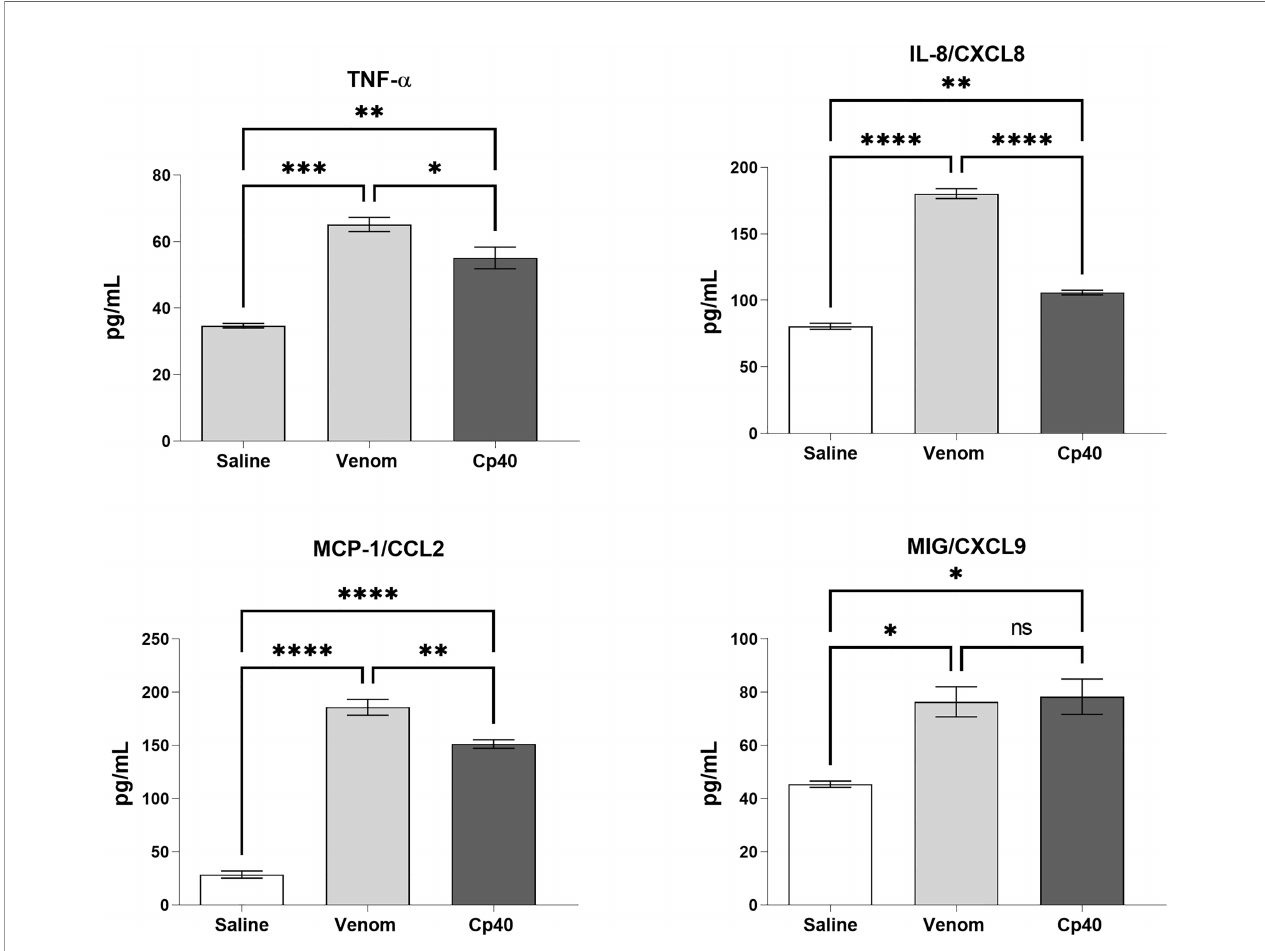
FIGURE 7 | Levels of TNF- a and chemokines in human blood stimulated by B. jararaca venom in the presence of Cp40. Human blood samples containing GPRP (8 mg/mL) were preincubated with Cp40 inhibitor (20 m M) and then incubated with B. jararaca venom (50.0 m g/mL) or sterile saline solution for 60 minutes at 37°C. After plasma collection and dilution (1:2), the presence of TNF- a and the chemokines IL-8, MCP-1 and MIG was evaluated by the Cytometric Bead Array (CBA). The results are presented as the mean ± SEM from three independent experiments. ns, not signi fi cant; * p ≤ 0.05, ** p ≤ 0.005, *** p ≤ 0.0005, **** p <